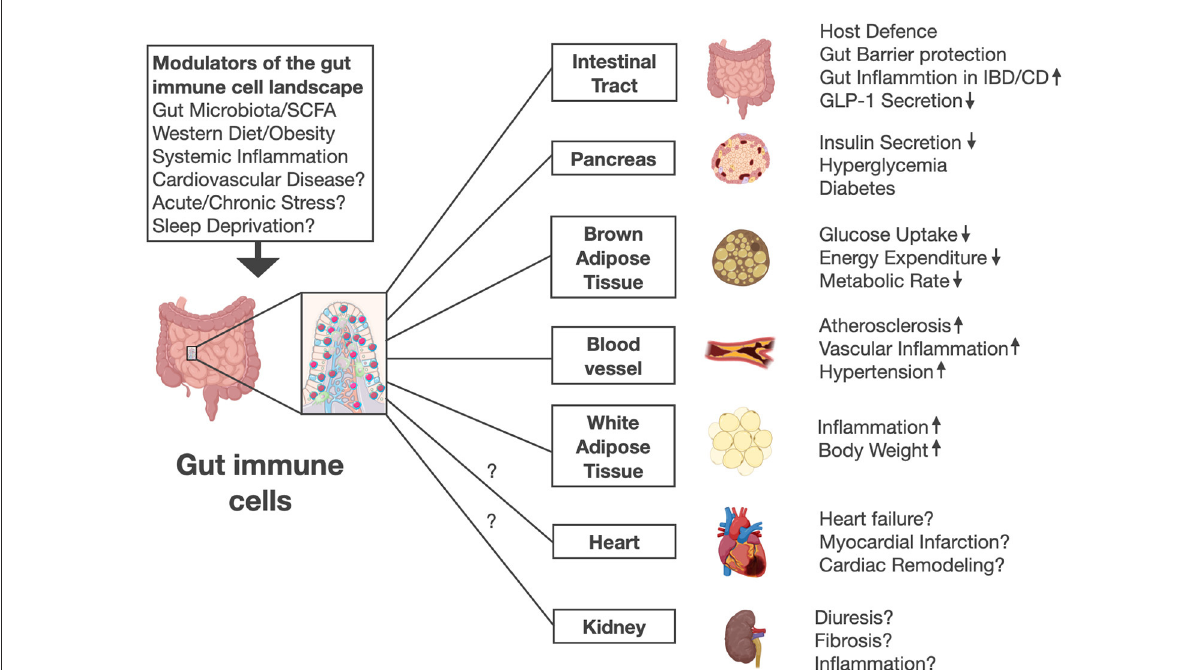
FIGURE1 Gut immune cells are modulated by gut microbiota, short chain fatty acids (SCFA), diet and systemic inflammation in mice. Future work is needed to investigate whether other stimuli and lifestyle factors including stress or sleep disorders affect gut immune cell numbers and activation. Intestinal immune cells mediate pleiotropic effects in various organs beyond their role in host defense and gut barrier protection. Mice lacking gut immune cells show increased insulin secretion, improved glucose control, higher energy expenditure, lower body weight, less high fat diet-induced adipose tissue inflammation, and increased circulating GLP-1 levels. Thus, gut immune cell deficient mice were protected against diabetes, obesity, hypertension and atherosclerosis. Future work needs to address whether gut immune cells might affect other diseases including heart failure, myocardial infarction, and kidney function. The illustration was modified from Biorender (https://Biorender.com).